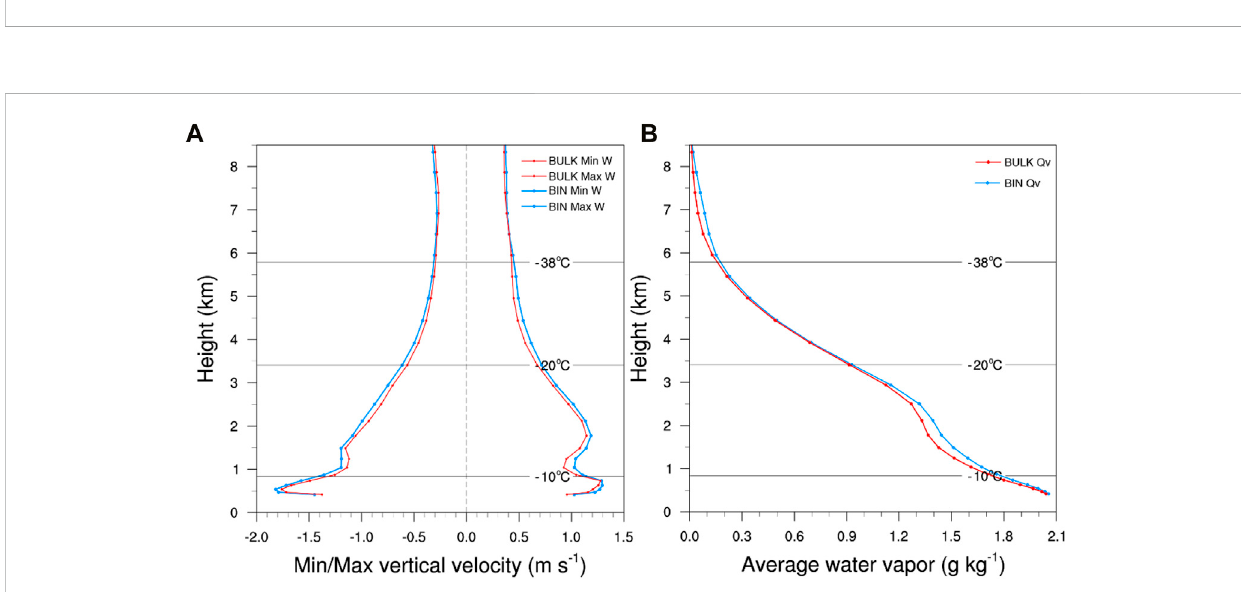
Vertical pro fi les of (A) maximum and minimum vertical velocity (unit: m s − 1 ) and (B) average water vapor mixing ratio (g kg − 1 ) simulated by the BULK and BIN schemes from 2000 UTC on February 12 to 1600 UTC on February 13, 2022. Regions used to calculate the vertical pro fi les are shown in Figures 4A3 –